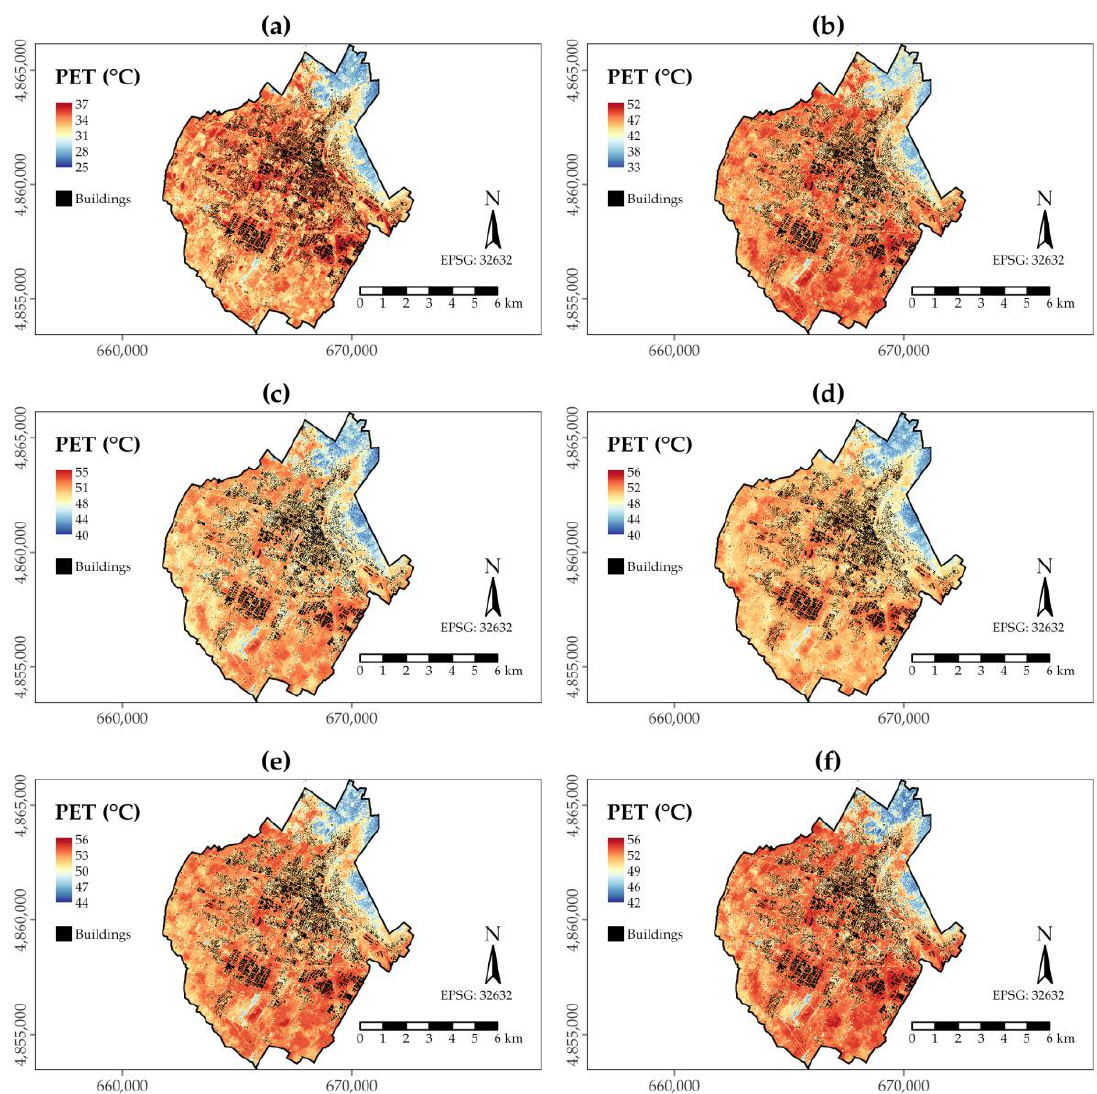
Figure 9. Physiological Equivalent Temperature (PET) maps of the study area at different daytimes: ( a ) h 07:00; ( b ) h 09:00; ( c ) h 11:00; ( d ) h 12:00; ( e ) h 13:00; ( f ) h 16:00.